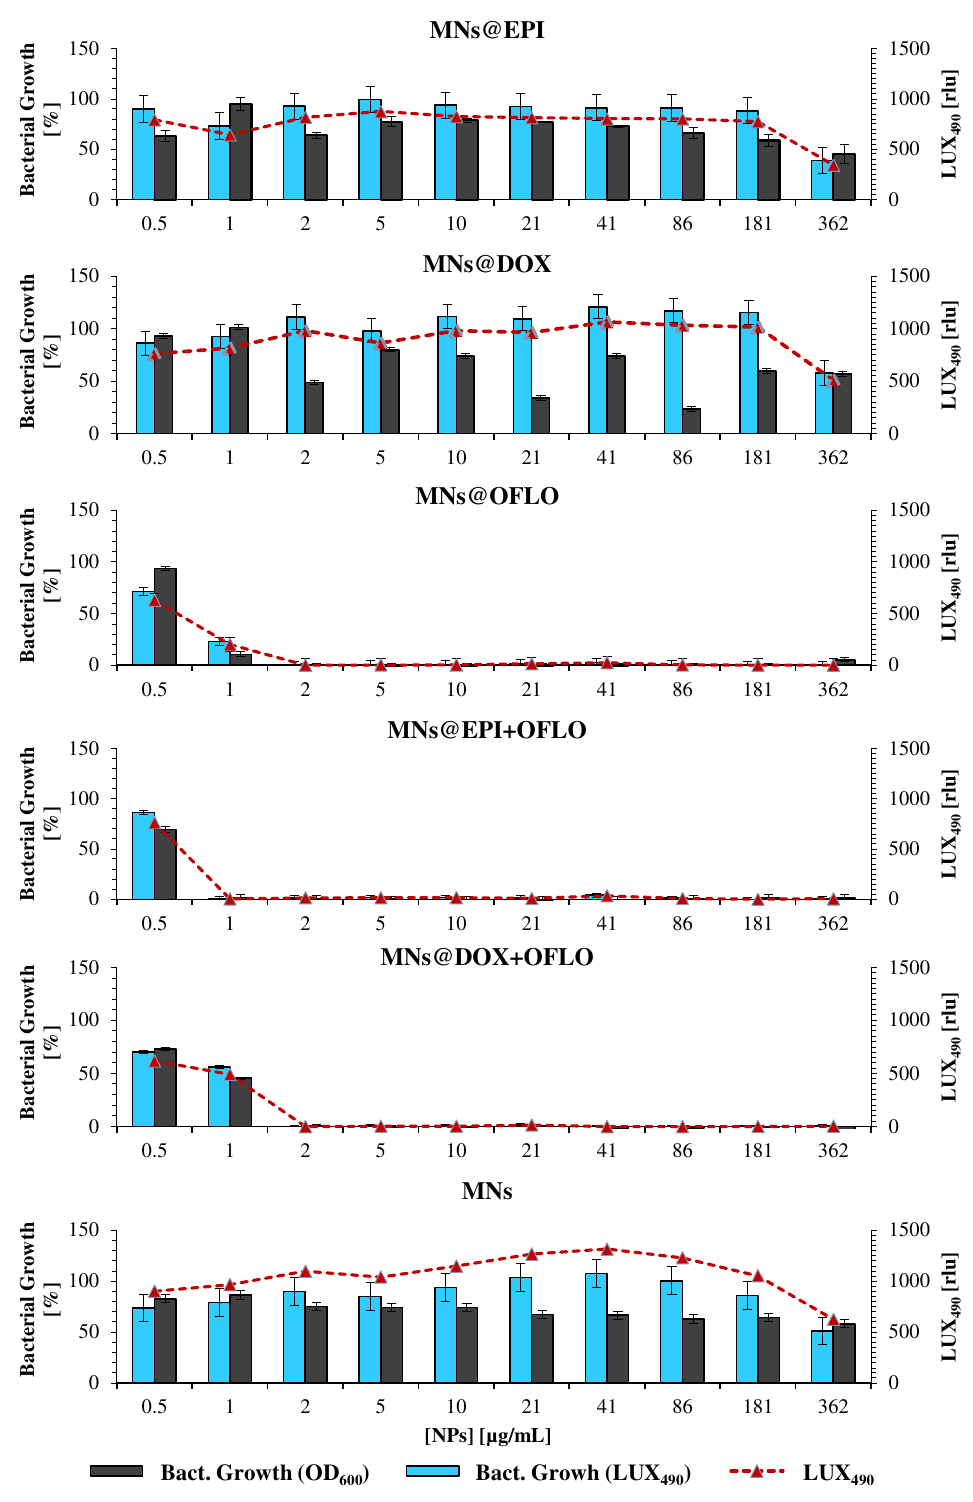
Figure 6. Antimicrobial activity of drug-loaded MNs on the mutant E. coli Lux strain, measured as bacterial growth calculated by OD 600 and LUX 490 , for 8 h assay; raw LUX 490 signal alone is depicted by the red dotted line and follows the same trend as the calculated bacterial growth.